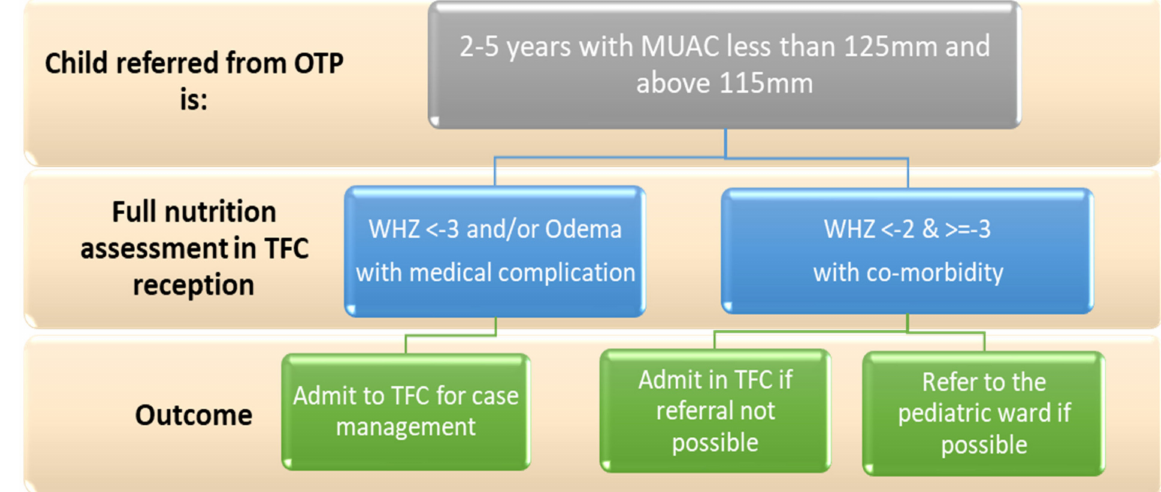
Figure 2. TFC admission criteria for 2–5 years old children with moderate acute malnutrition. Abbreviations: MUAC: mid-upper arm circumference; OTP: outpatient therapeutic program; TFC: therapeutic feeding center; WHZ: weight-for- height